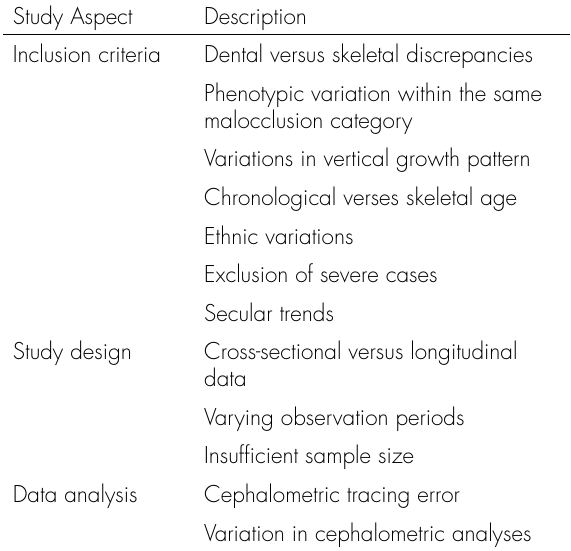
Table I. Limitations of growth Study Aspect